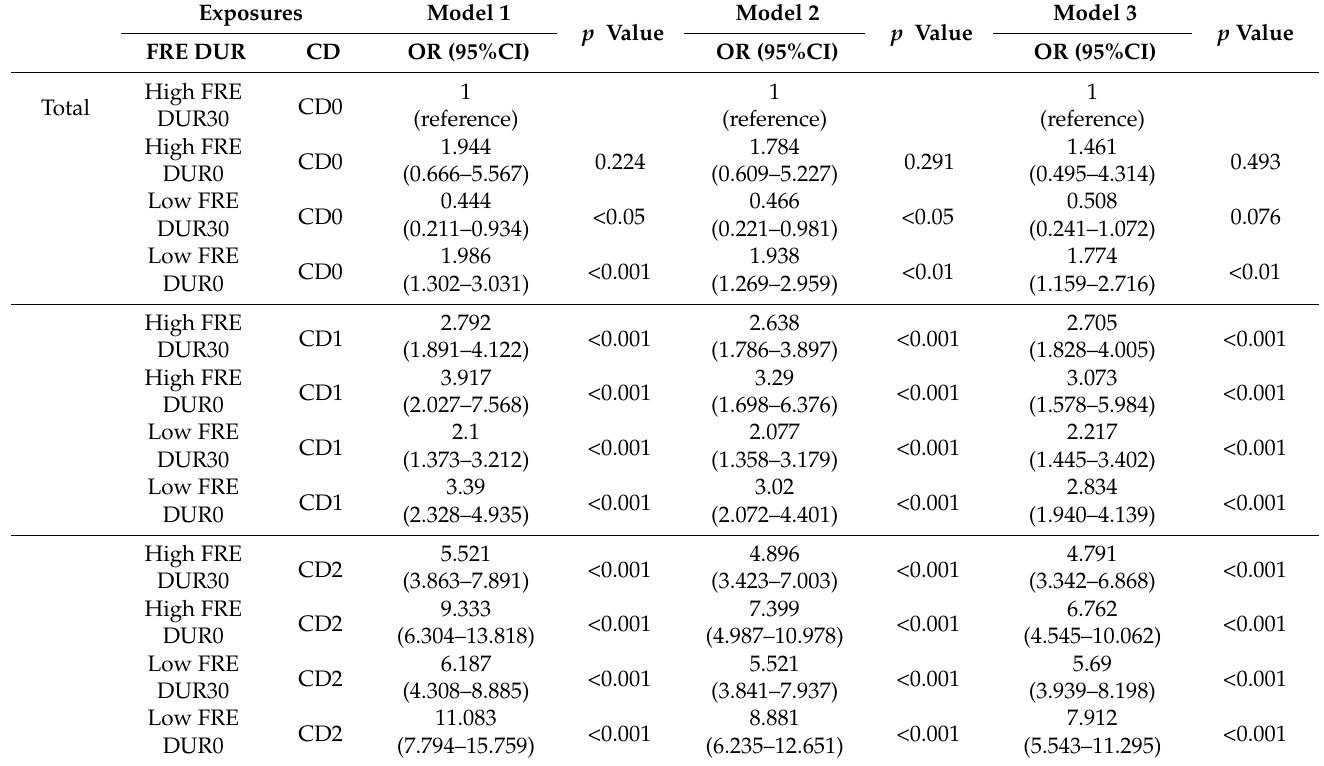
Table 4. Combined effects of frequency and duration and the number of diseases on